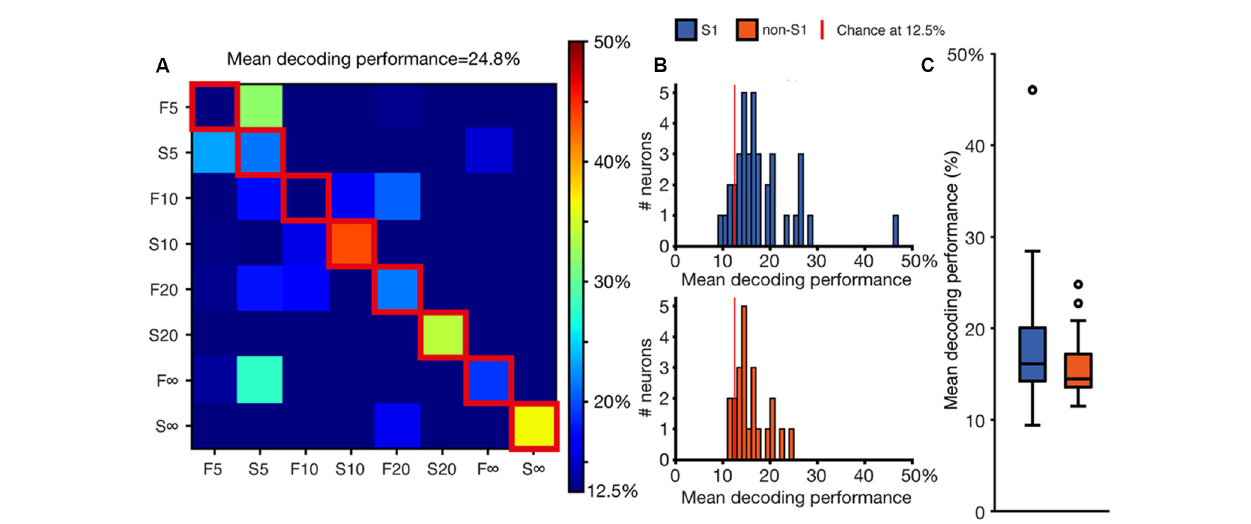
FIGURE 3 | Decoding performance at the single neuron level. (A) A confusion matrix illustrating the degree of specificity of the spike responses to the different stimulation patterns for the sample neuron also shown in Figure 2 . (B) Mean decoding performance across the population of neurons. Chance decoding level is at 12.5% (for the comparison between eight stimulation patterns) as indicated by the red vertical line. (C) Box plot of the mean decoding performance for S1 ( N = 44) and non-S1 ( N = 24) neurons, respectively.